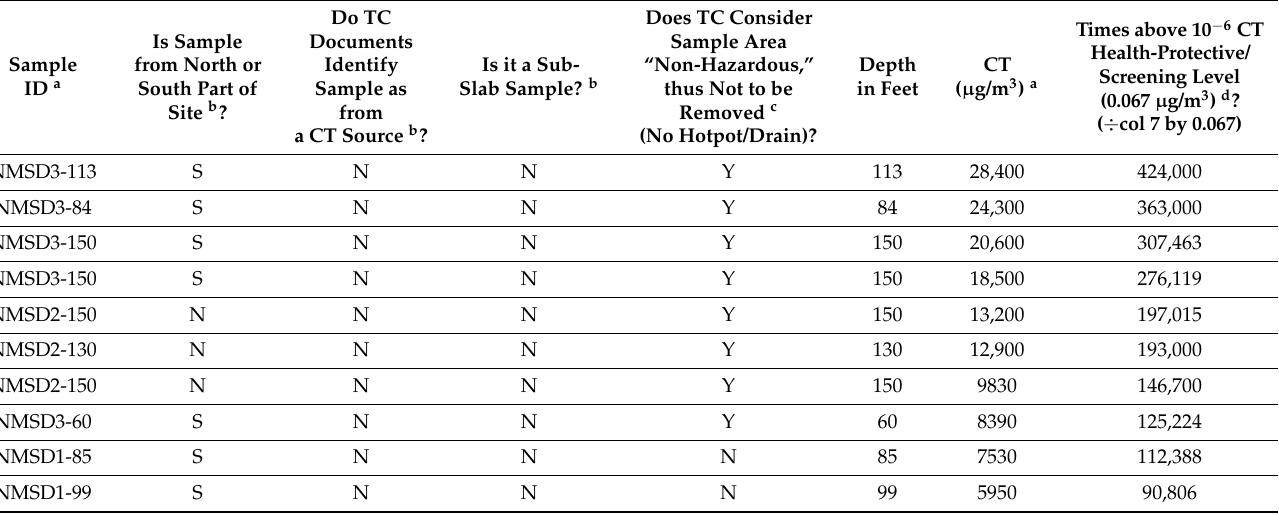
Table 2. Highest of 172 known soil-gas-VOC-violation locations a for carbon tetrachloride (CT), single or temporary-well samples, NOTSPA, Pasadena,